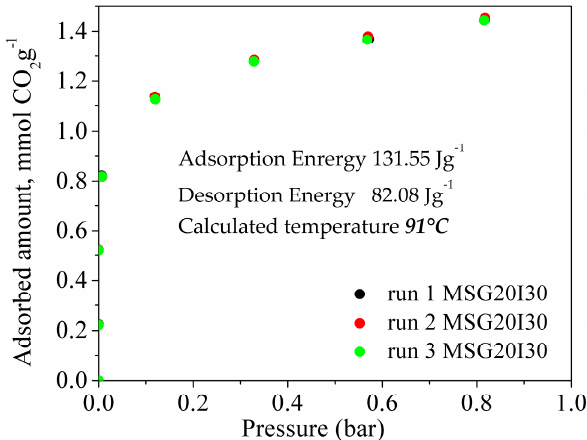
Figure 12. CO 2 Adsorption Isotherms with regeneration temperature in addition to molecular vacuum, for MSG20I30 sample at 91 °C.